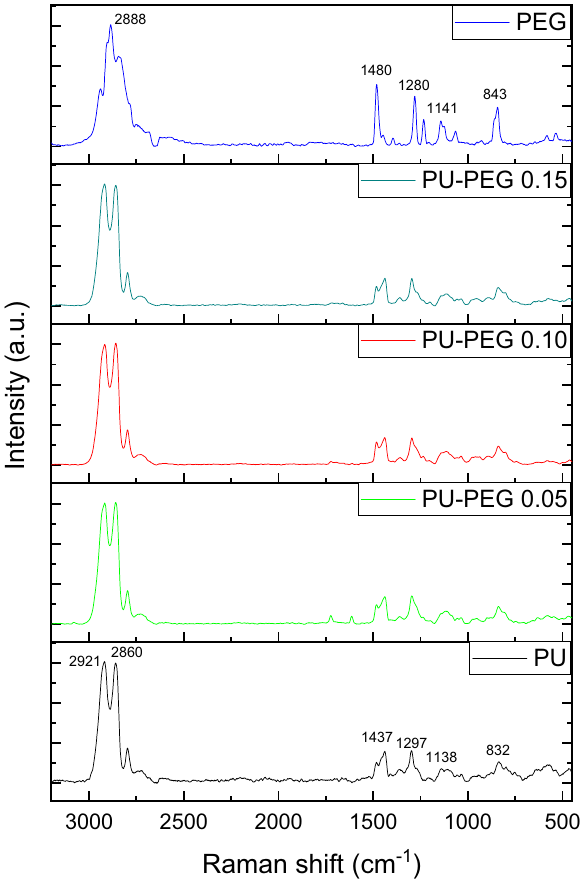
Fig. 4 Raman spectra of the PU fi lms and